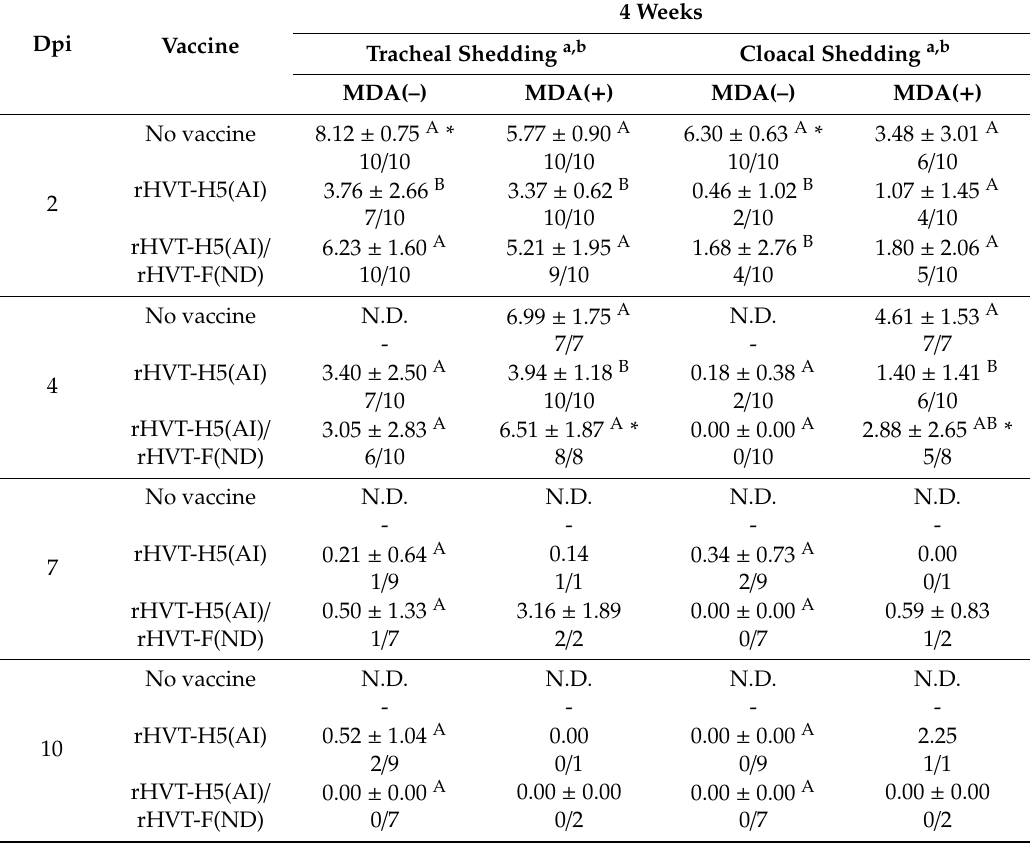
Table 8. Tracheal and cloacal shedding of H5-HPAIV after challenge at 4 weeks of age with H5-HPAIV to LBL layer chickens (experiment II) vaccinated at day-old with rHVT-F(ND), rHVT-H5(AI), or both